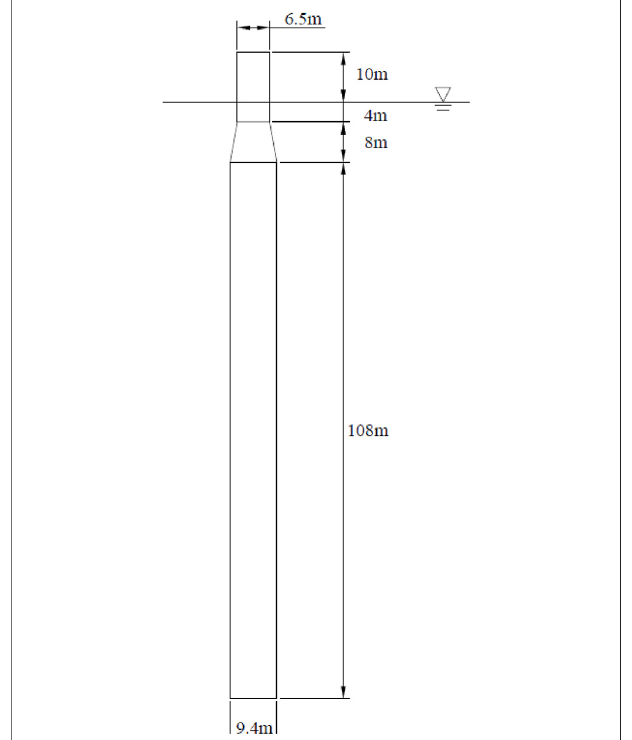
FIGURE 1 | Principal